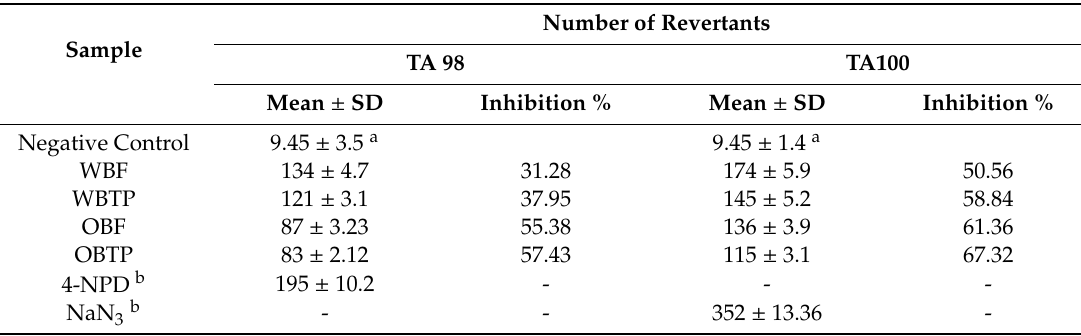
Table 5. Antimutagenic activity toward S. typhimurium TA98 and